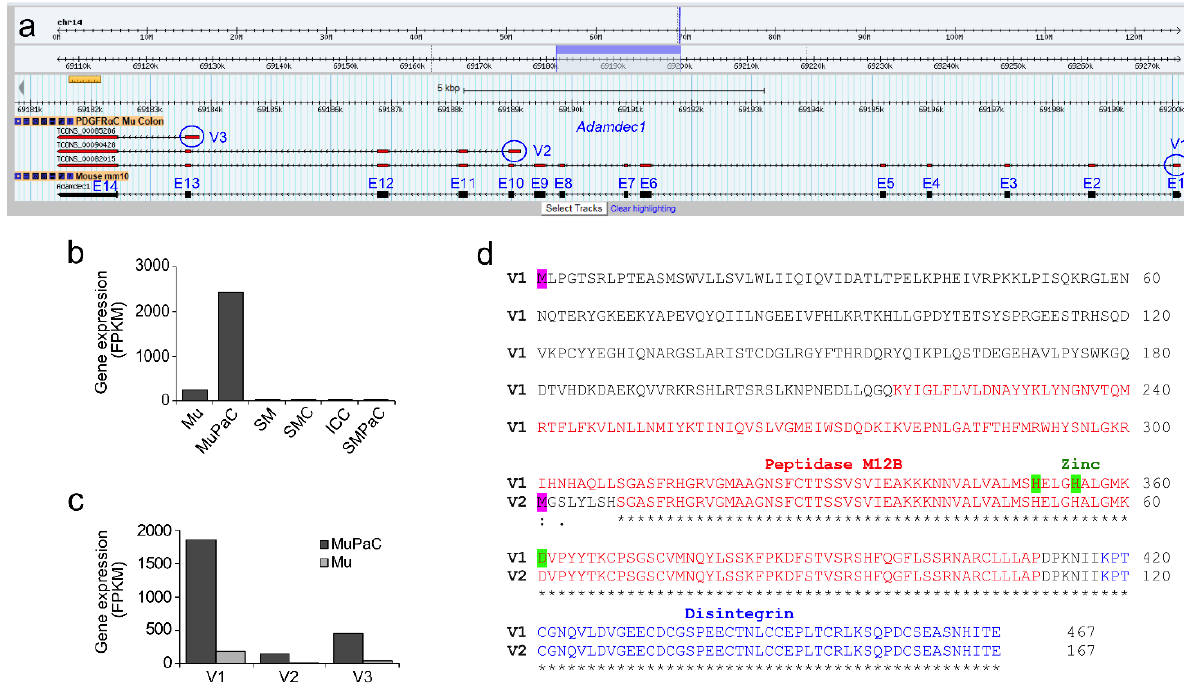
Figure 1. Adamdec1 transcripts are selectively expressed in colonic mucosal PDGFR α + cells. ( a ) A genomic map view of three Adamdec1 transcriptional variants (V1-3) expressed in colonic mucosal PDGFR α + cells. Three alternatively start exons (E1, E10 and E13) are circled (blue). ( b ) Expression levels of Adamdec1 in isolated colonic cells and tissue: mucosa (Mu), mucosal PDGFR α + cells (MuPaC), smooth muscle (SM), smooth muscle cells (SMC), interstitial cells of Cajal (ICC), and smooth muscle PDGFR α + cells (SMPaC). ( c ) Expression levels of Adamdec1 variants in Mu and MuPaC. ( d ) Alignment of predicted amino acid sequences of ADAMDEC1 variants. The open reading frame was identified for each variant and predicted amino acid sequences were aligned. Alternative starting methionines (M) are in pink. The peptidase M12B domain and Disintegrin domain are indicated by red and blue respectively. Three zinc binding sites are marked by green.